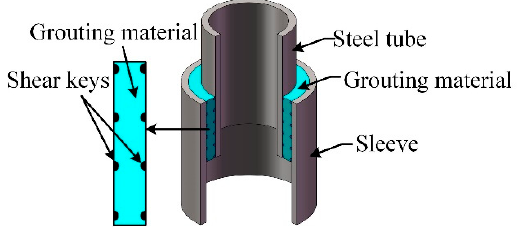
Figure 1. Sleeve grouting connection of the concrete-filled steel tube column.